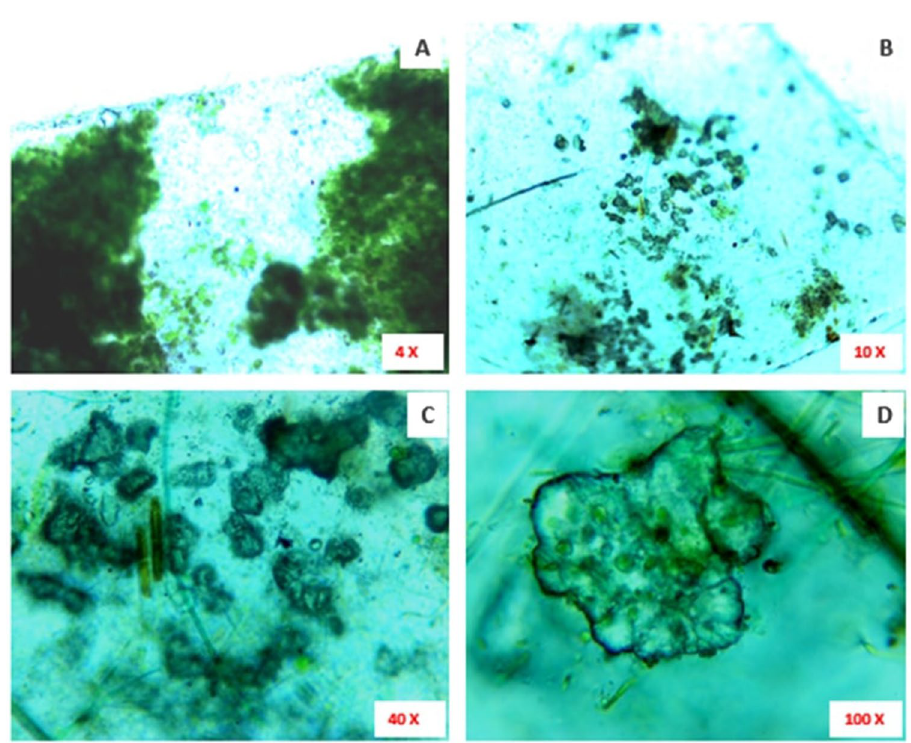
Figure 3. ( A ) The microscopic image (× 10 magnification) showing the colonization of green photosynthetic microalgae on the surface of the collected plastic sheet from the sampling site; ( B ) The × 10 magnification of collected waste plastic sheet showing erosions on its surface; ( C ) The × 40 magnification also represents the erosions on the surface of the collected plastic sheet; ( D ) The × 100 magnification showing a part of eroded surface on the collected plastic